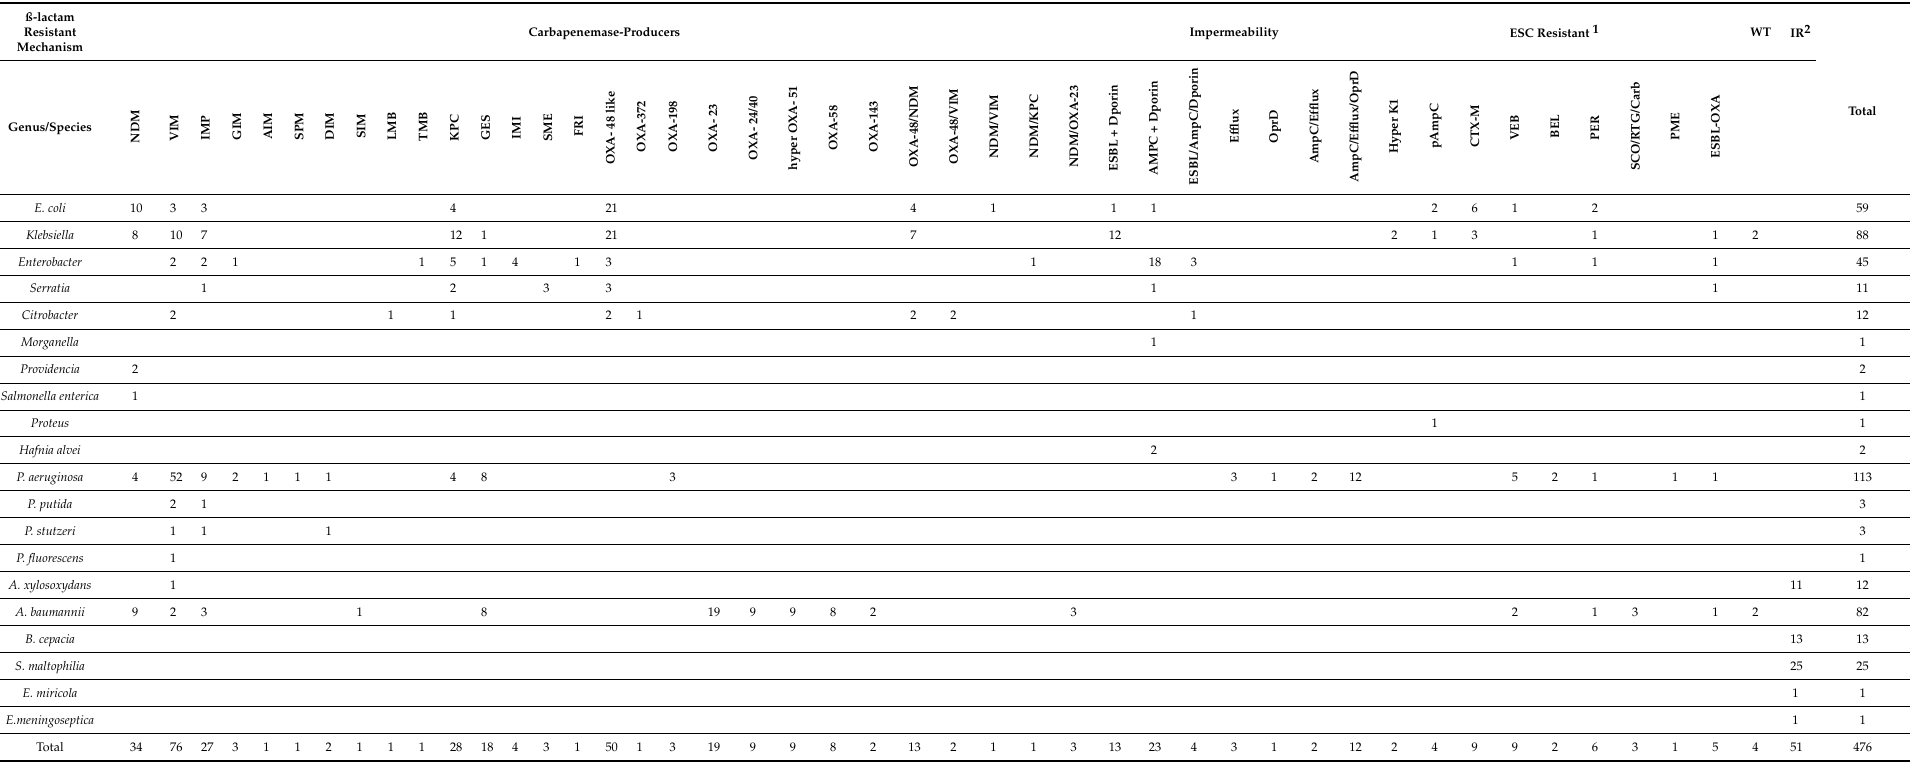
Table 1. Panel of tested